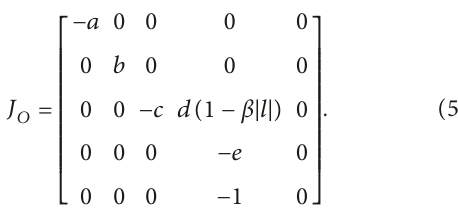
− x plane, and (d) x 2 3